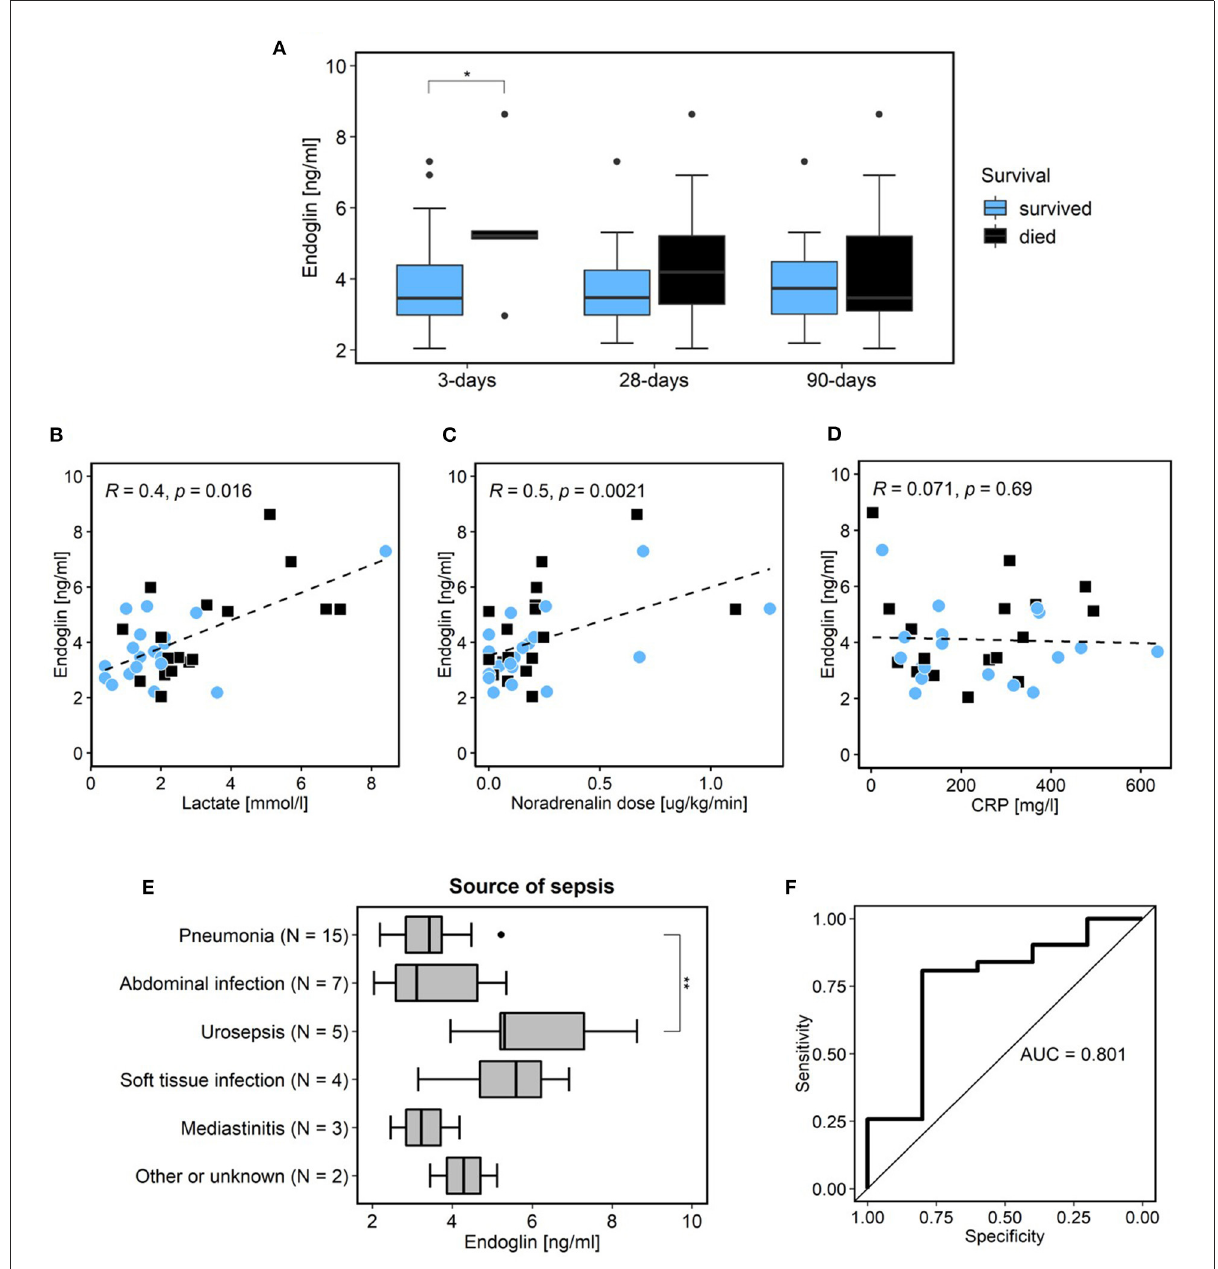
FIGURE1 Septic shock cohort. Relationship of patient survival and level of sEng [blue color survivors; black color non-survivors; (A) ]. Correlations of sEng and lactate (B) , noradrenalin dose (C) , and CRP [ (D) ; blue dots survivors; black squares non-survivors]. Relation of sEng level and sepsis source (E) . Statistical difference between various source of sepsis (Kruskal-Wallis test; p = 0.014) and statistical significance between urosepsis and pneumonia (Wilcox test with Holm correction; p = 0.007). Receiver operating curve of sEng with calculated AUC for prediction of 3 days mortality (F) . *Indicates statistical significance ( p < 0.05). sEng, soluble endoglin; SOFA, sequential organ failure assessment; CRP, c-reactive protein; AUC, area under the curve. **Indicates statistical significance between urosepsis and pneumonia (Wilcox test with Holm correction; p =